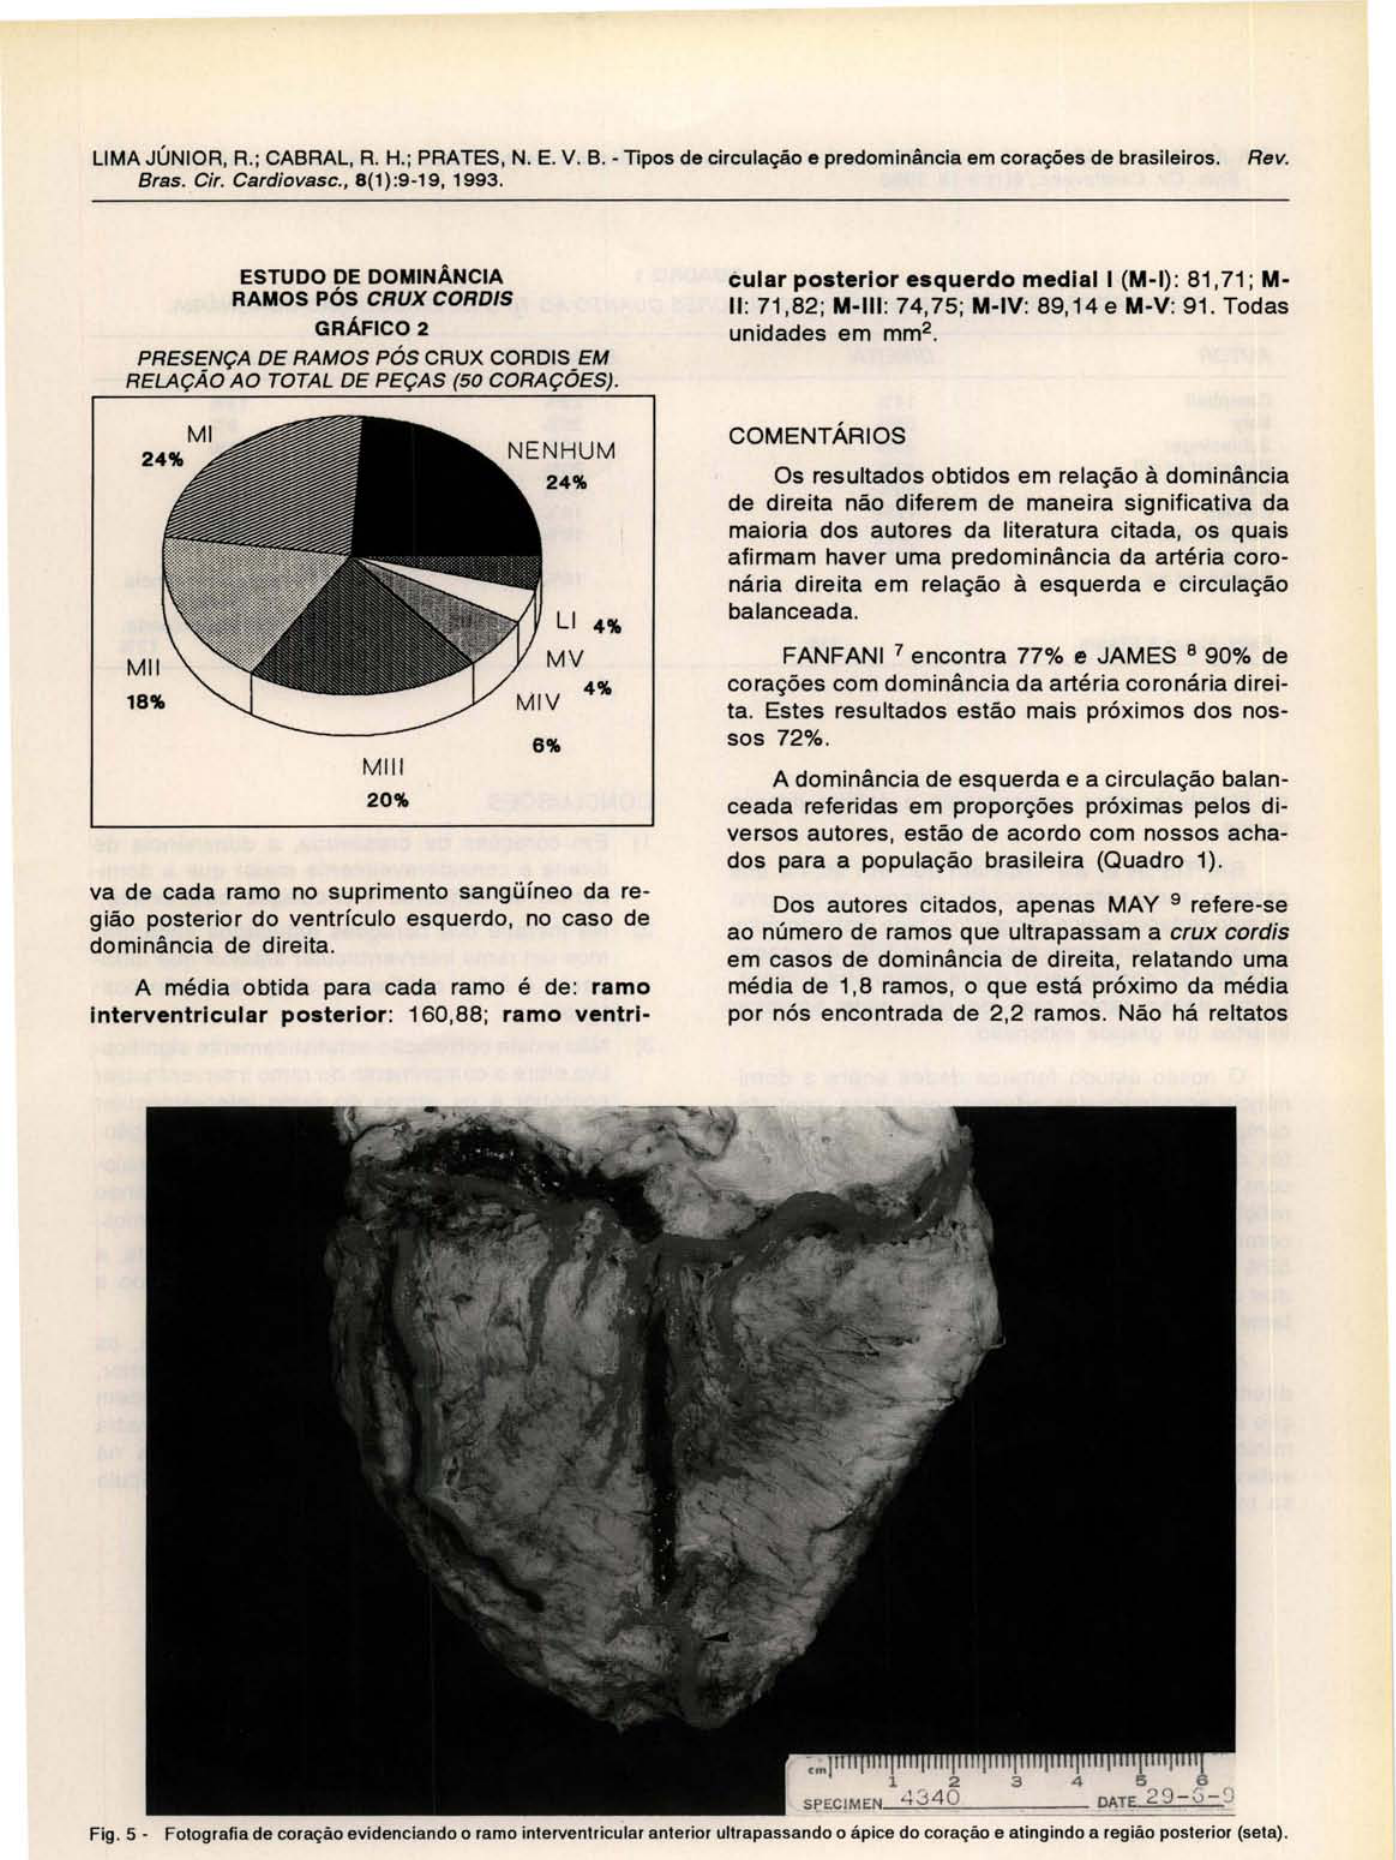
Fig. 5 - Fotografia de coração evidenciando o ramo interventricu"ar anterior ultrapassando o ápice do coração e atingindo a região posterior